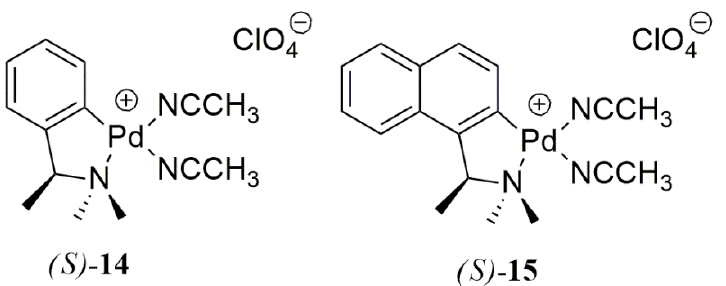
Figure 5. Palladium complexes 14 and 15 for the bisphosphines’ resolution.